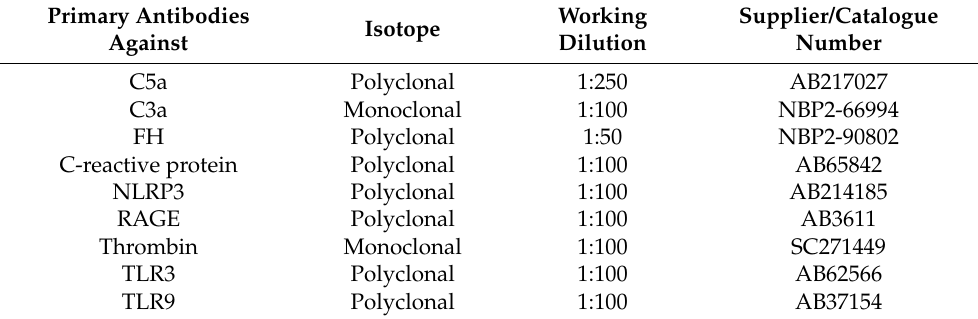
Table 1. List of primary